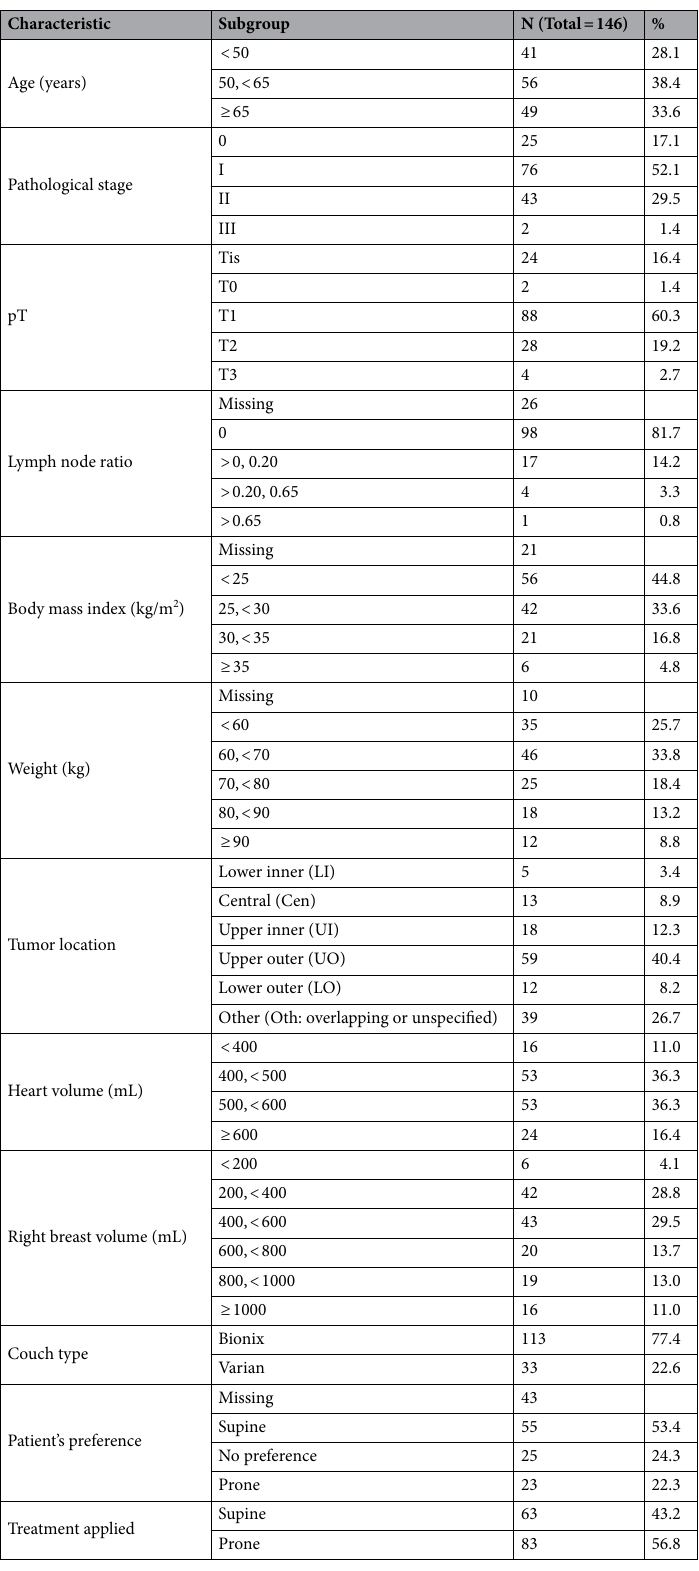
Table 1. Patient’s